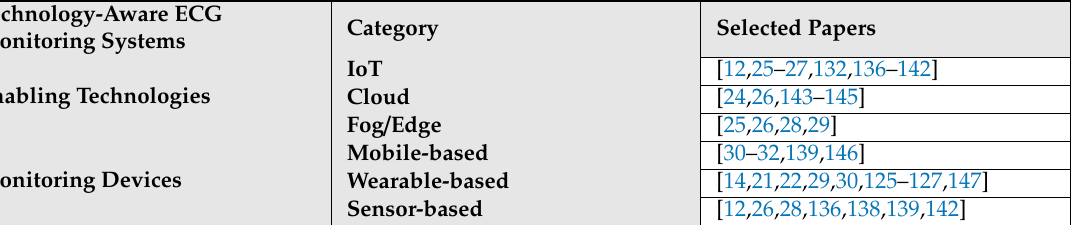
Table 3. Classification of selected technology-aware ECG monitoring